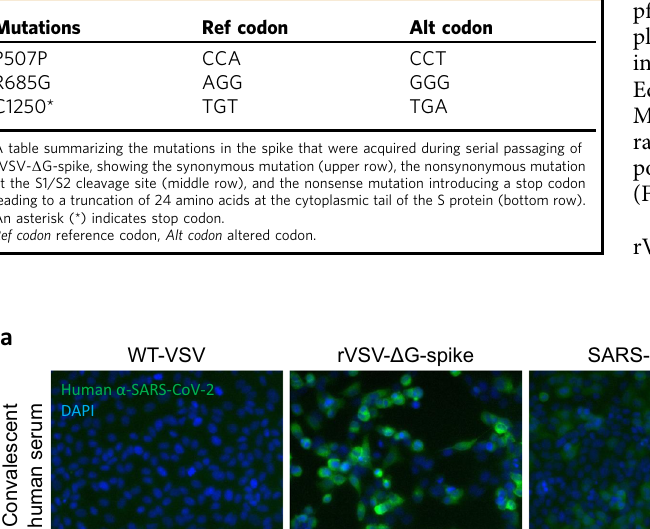
Table 1 Spike mutations acquired during serial passaging.